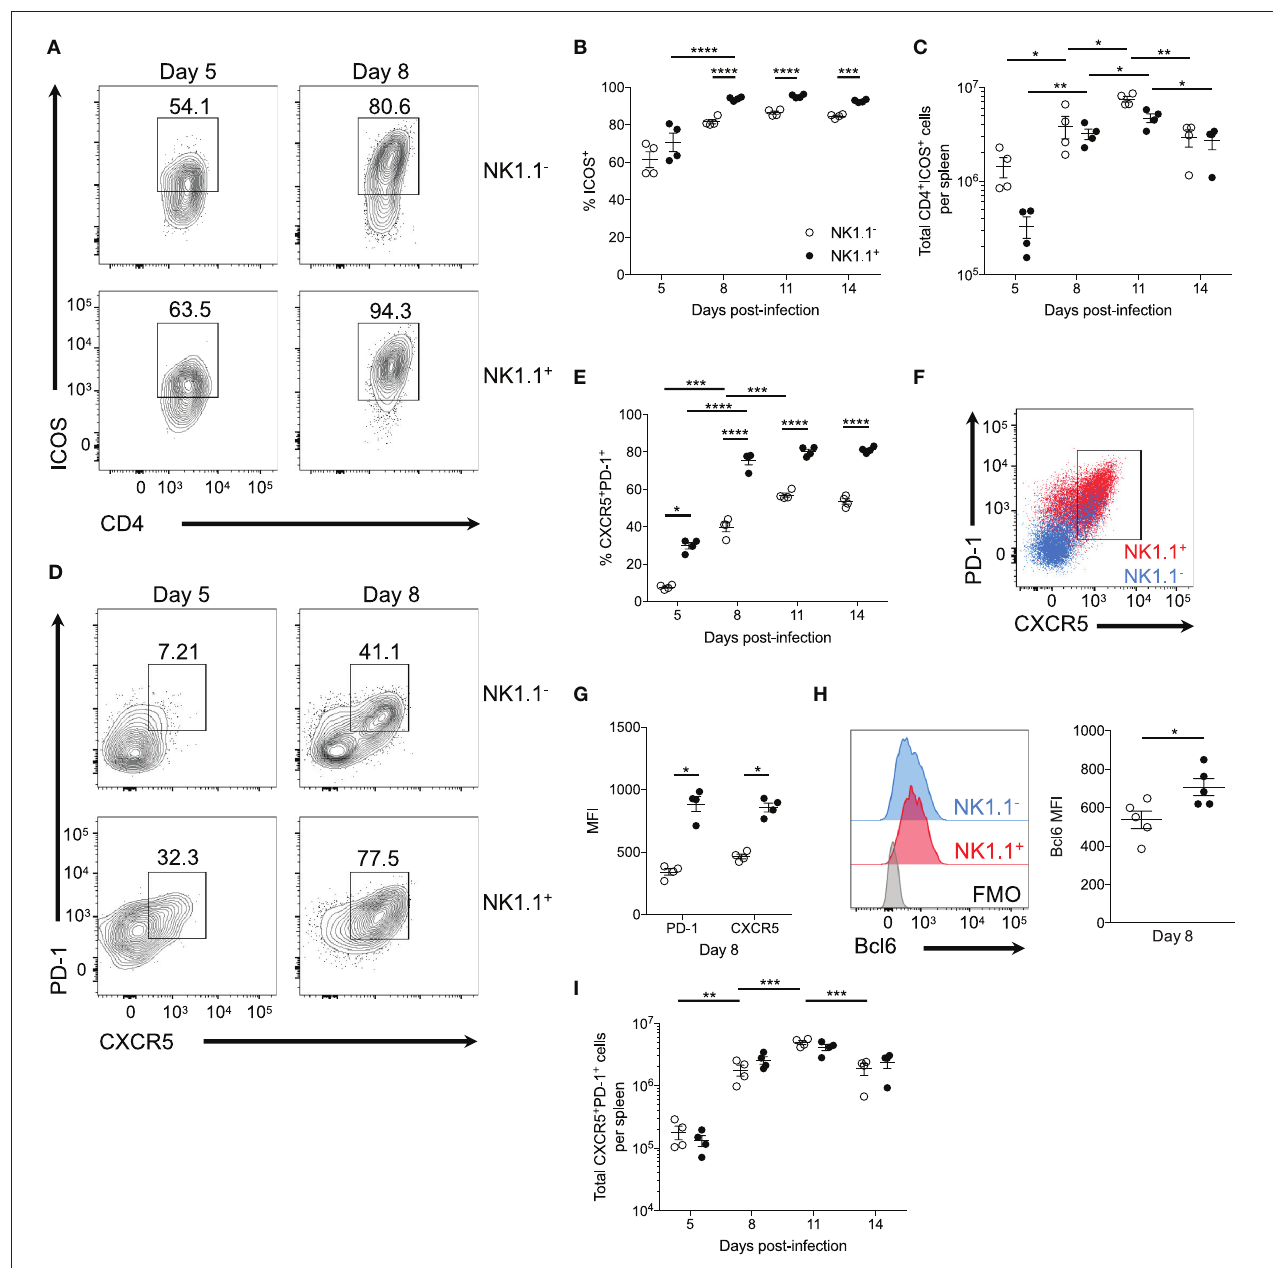
FIGURE 4 | NK1.1 + CD4 + T cells are primarily Tfh-like cells. (A) Representative ICOS expression among live activated (CD44 hi CD62L lo ) NK1.1 positive and negative CD4 + TCR β + T cells at days 5 and 8 post-infection. (B) Frequency of ICOS expression among live activated NK1.1 negative or positive CD4 + T cells between days 5 and 14 post-infection. (C) Total number of live activated NK1.1 − or NK1.1 + ICOS + CD4 + TCR β + T cells per spleen. (D) Representative PD-1 and CXCR5 expression on live activated NK1.1 negative or positive CD4 + T cells at days 5 and 8 post-infection. (E) Frequency PD-1 + CXCR5 + of live activated CD4 + TCR β + T cells. (F) PD-1 and CXCR5 expression overlay of NK1.1 + (red) or NK1.1 − (blue) CD4 + TCR β + T cells at day 8 post-infection. (G) MFI of PD-1 and CXCR5 expression. (H) Intracellular Bcl6 staining of live activated NK1.1 + or NK1.1 − CXCR5 + PD-1 + cells at day 8 post-infection and MFI of Bcl6 expression. (I) Total number of live activated NK1.1 positive or negative CXCR5 + PD-1 + cells at day 8 post-infection. MFI, median fluorescence intensity. (B,C,E,I) An aligned rank transformation was performed on non-parametric data before determining significance by two-way ANOVA with a post hoc Holm-Sidak’s multiple comparisons test. * p < 0.05, ** p < 0.01, *** p < 0.001, **** p < 0.0001. (G,H) Significance assessed via an unpaired non-parametric Mann-Whitney test. * p < 0.05. Data are representative of three independent experiments (error bars,